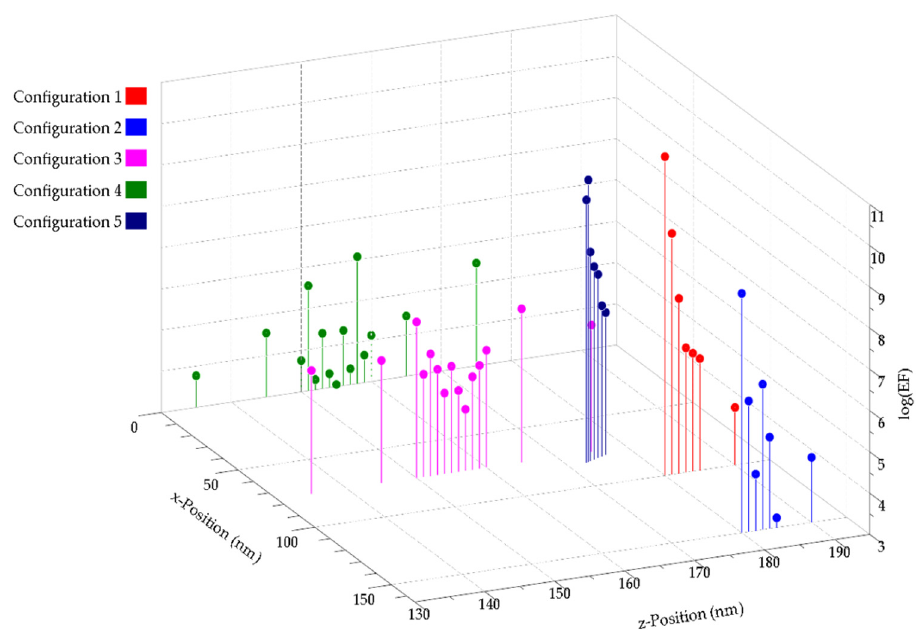
Figure 8. Summary of the Ag-NP-on-Ag-NHA G SERS value variation for different positions in the z -axis for Configurations 1–5.